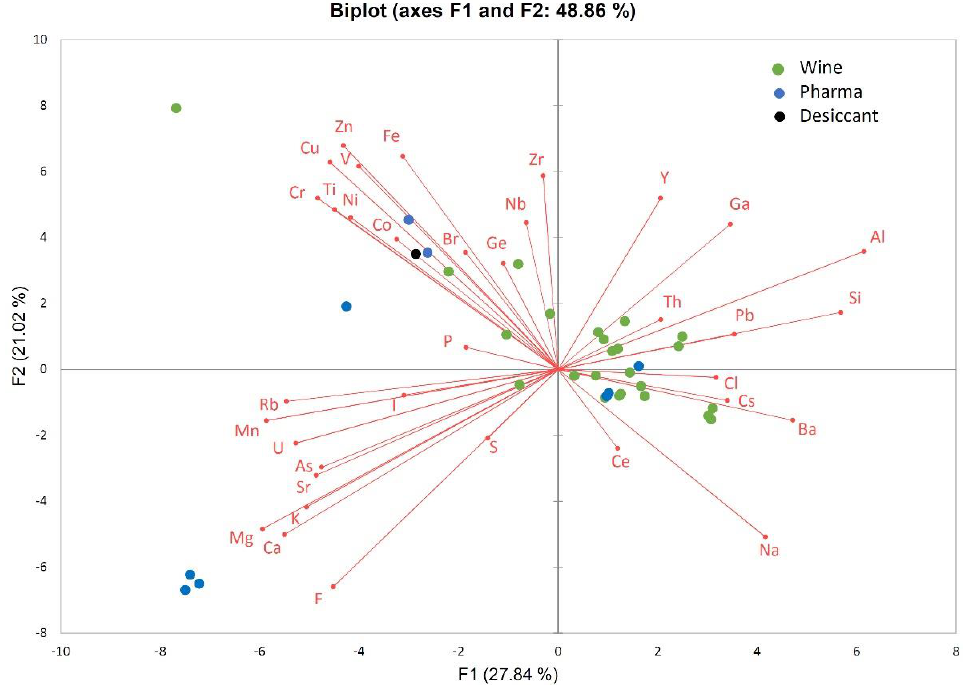
Figure 2. Principal component analysis of the elemental composition of the dry bentonites. Samples are grouped by intended use as wine-fining agent, pharma/beauty product, or desiccant.